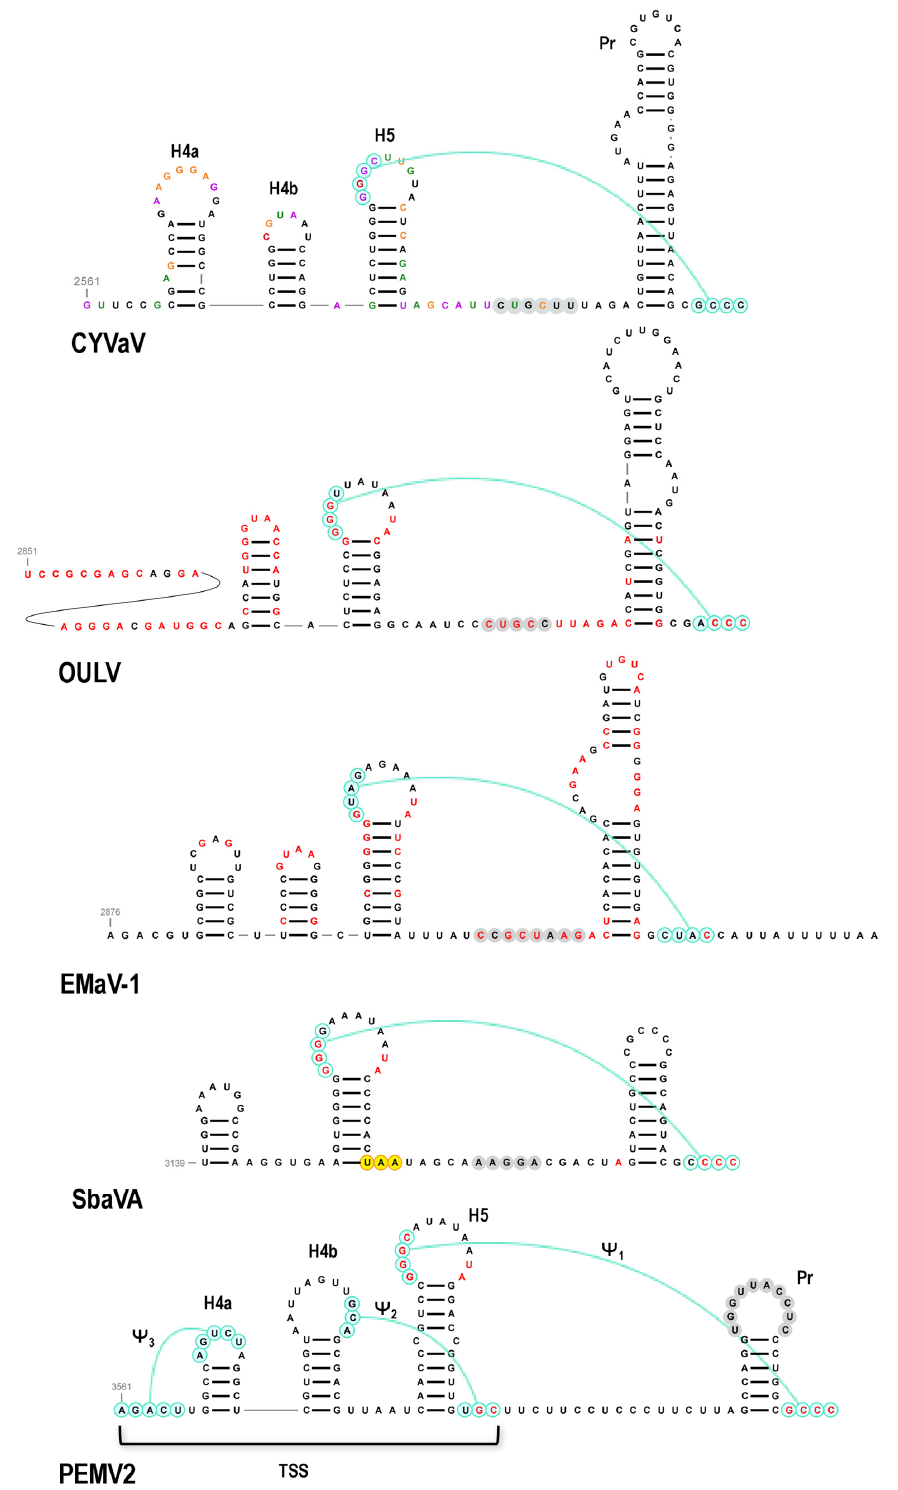
Figure 12. 3 (cid:48) terminal regions of Class 2 and Class 3 ulaRNAs and umbravirus PEMV2. Nomenclature for 3 (cid:48) hairpins and pseudoknots were originally developed for TCV [75]. Three hairpins and 2 pseudoknots comprise a ribosome-binding, T-shaped structure (TSS) that serves as one of three 3 (cid:48) CITEs in PEMV2 and is structurally conserved in many umbraviruses and two betacarmoviruses. CYVaV and EMaV contain the corresponding hairpins of the TSS but not the pseudoknots. Since all umbraviruses and carmoviruses contain Ψ 1 at their 3 (cid:48) termini, it is unclear if the additional downstream sequence in EMaV is correct. The termination codon for ORF5-1 in SbaVA is in